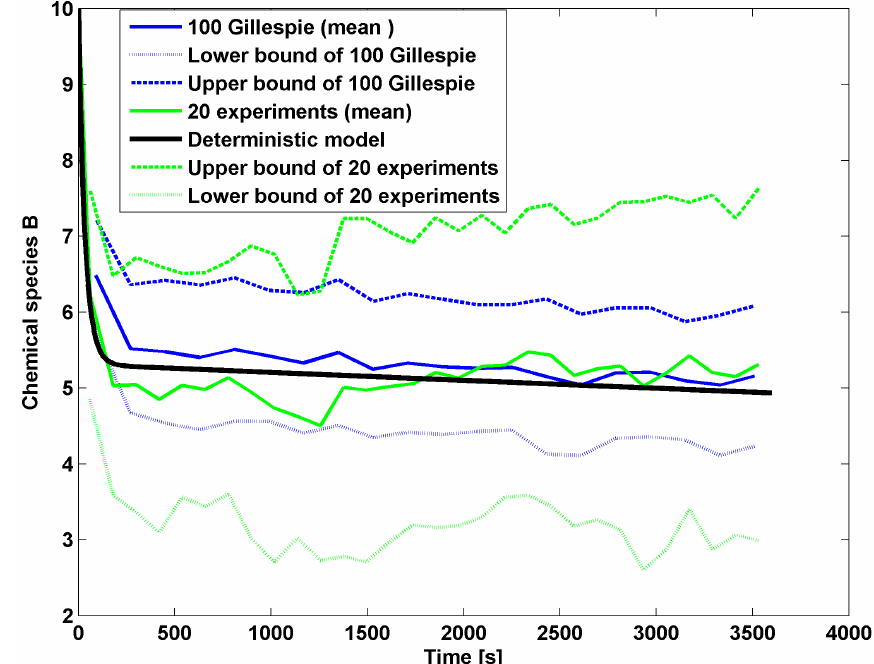
Figure 5. Fitting abundance of species B. Blue curve: average of 100 simulations of the stochastic model with Gillespie algorithm. Green curve: the average of the experimental data. Red dotted and dash-dotted curves indicated the variance. The black line is the solution of the deterministic chemical model for the species B .